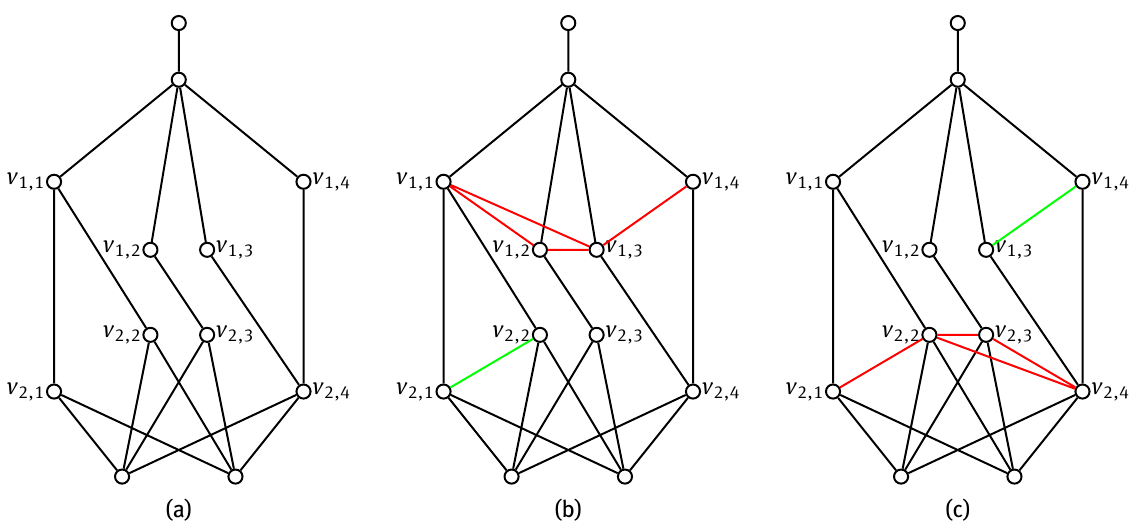
Figure 5: (a) A graph G with V 1 = { v 1,1 , v 1,2 , v 1,3 , v 1,4 } a set of co-transmission cousins to V 2 = { v 2,1 , v 2,2 , v 2,3 , v 2,4 } . (b)